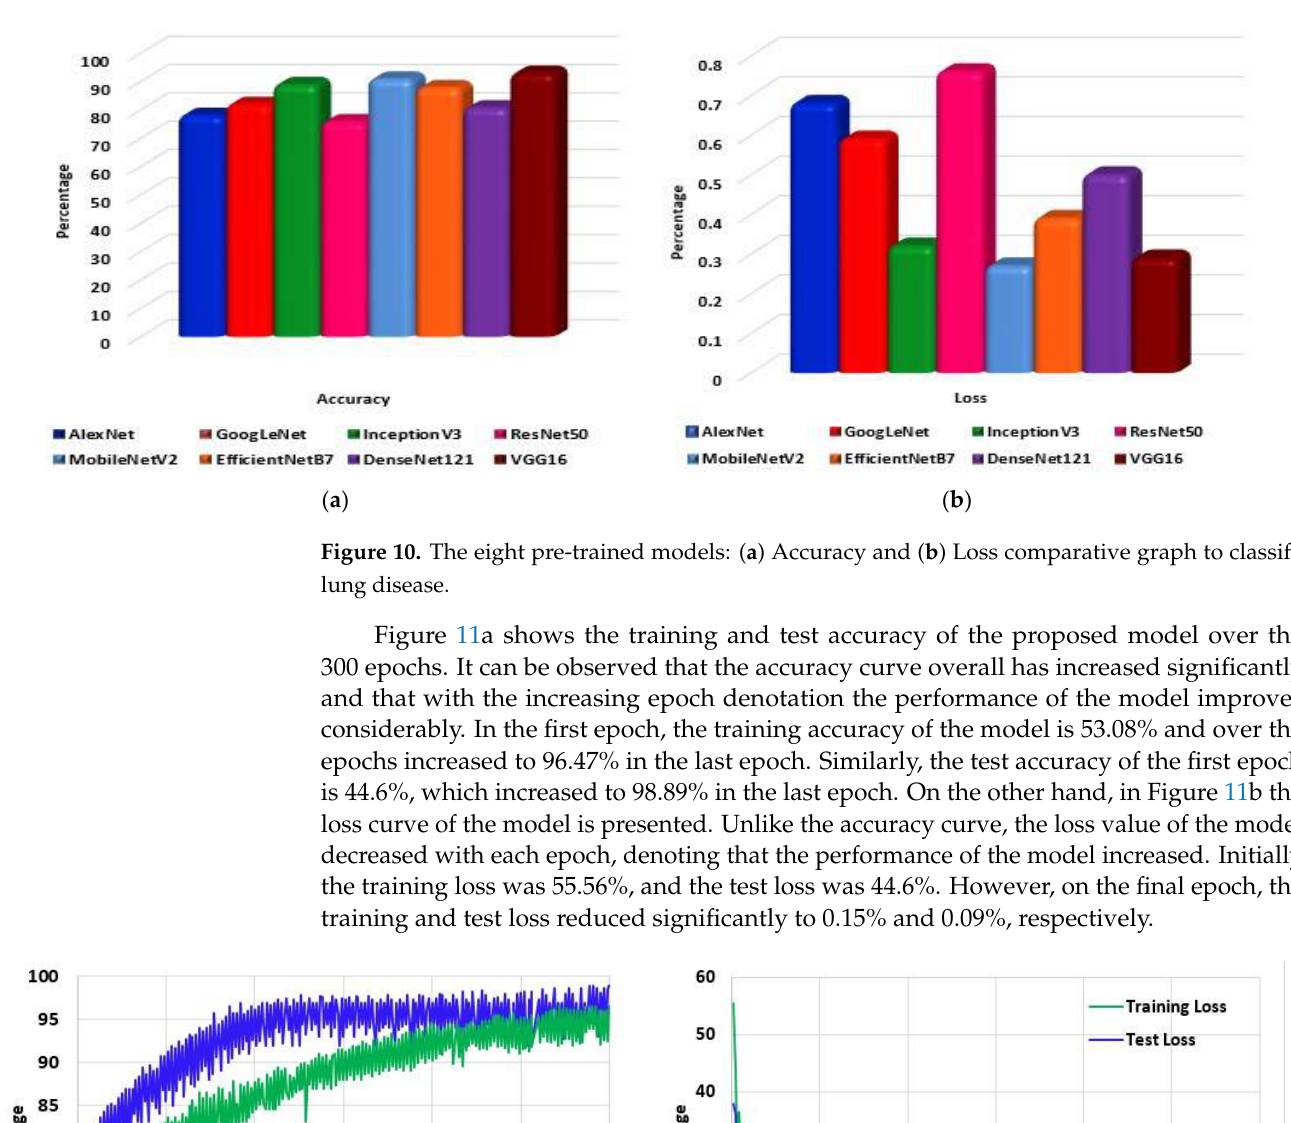
Figure 12. Confusion matrix for LungNet22 model. From the confusion matrix in Figure 12, the performance of Lungnet22 is calculated. To determine the performance, measures such as accuracy, precision, recall, specificity, and f1-score are considered where accuracy refers to the percentage of corrected classified